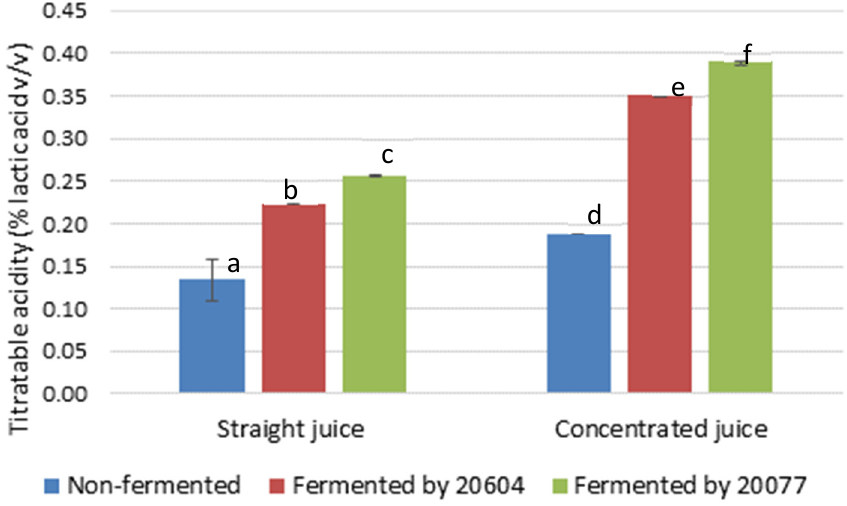
Figure 2. The titratable acidity in straight and concentrated juices before and after fermentation by L. gasseri strains. Different letters within a group represent significant difference ( p < 0.05).